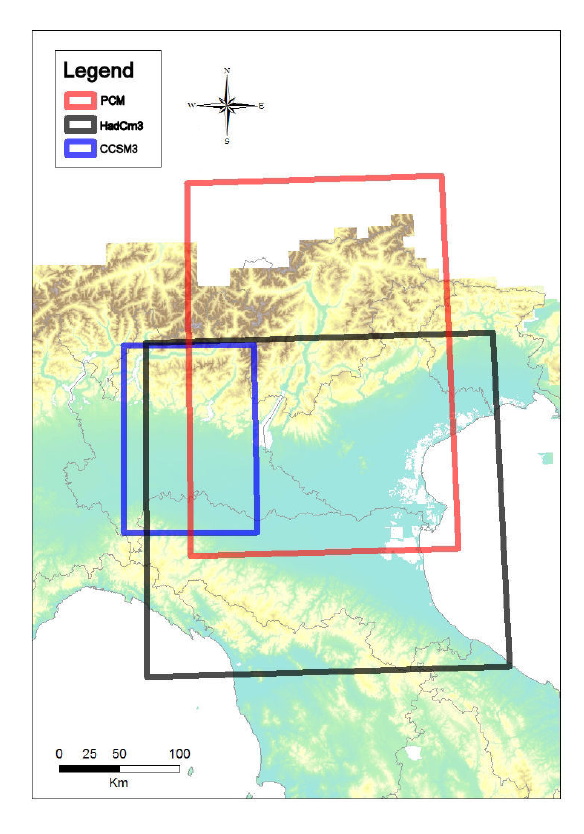
Fig. 2. Grids of the chosen GCM models upon the Oglio watershed. (SRE) coupled with maximum likelihood estimation, by the Expectation Maximization algorithm, EM (see e.g. Gupta et al., 2006).